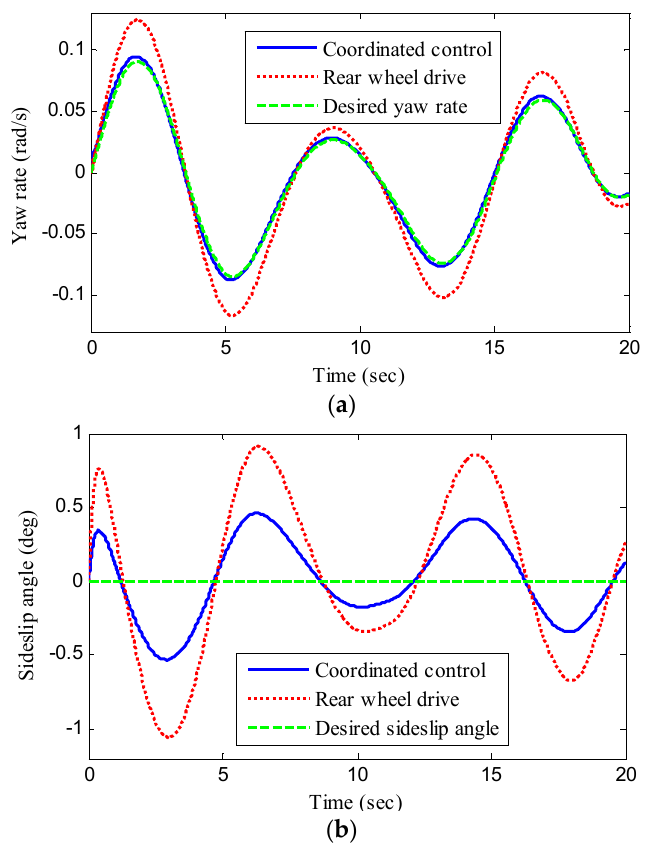
Figure 12. Results of vehicle stability control in case study 1. ( a ) Yaw rate; ( b ) Sideslip angle.